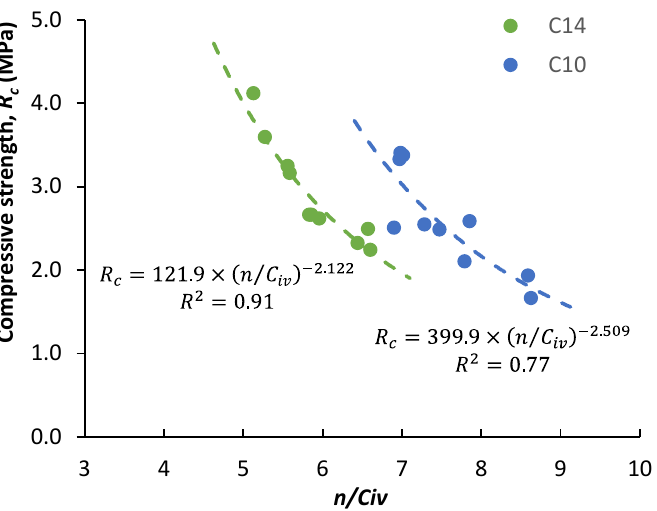
Figure 9. Effect of porosity on unconfined compressive strength and modulus of elasticity. The influence of the ratio of porosity to volumetric cement content on the unconfined compressive strength is shown in Figure 10. The ratio n/C iv varies between 5.1 and 8.6 for the different CBS specimens, and their strength varies in opposition to the n/C iv value. The relationships between R c and n/C iv are different for the CBS specimens fabricated with different cement contents but the agreement with the experimental results is good. By dividing the porosity by the volumetric cement content, it was assumed that an increase in porosity could be counteracted by a proportional increase in the volumetric cement content, keeping the unconfined compressive strength unchanged.